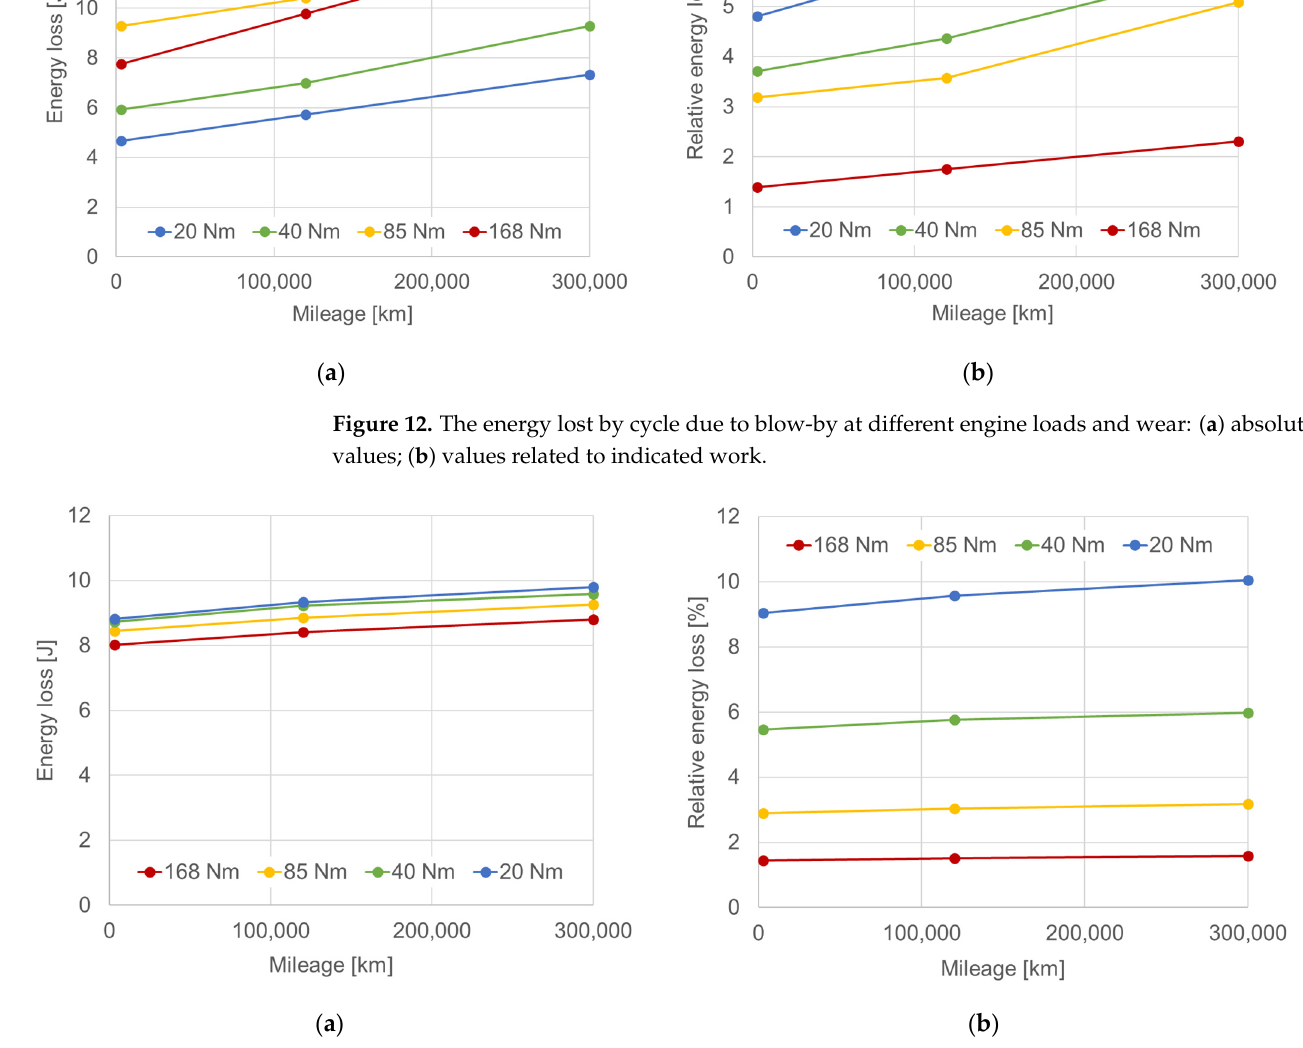
Figure 12. The energy lost by cycle due to blow-by at different engine loads and wear: ( a ) absolute values; ( b ) values related to indicated work.